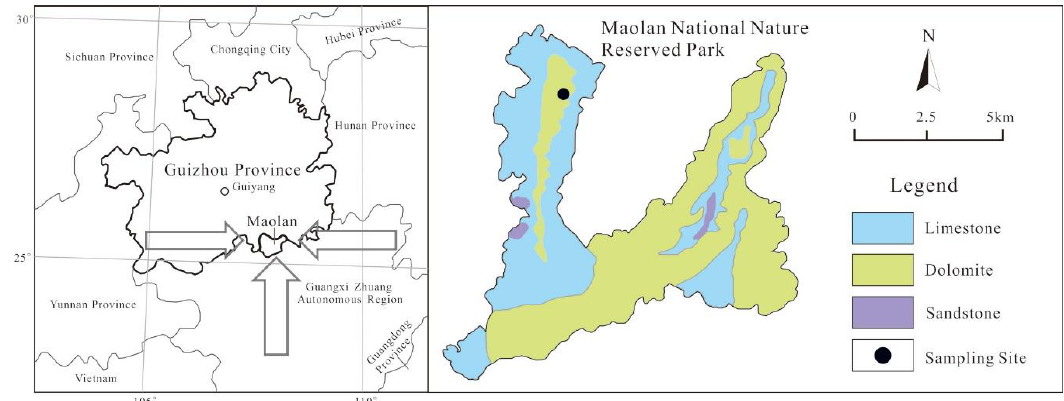
Figure 1. Background of the sampling site in the Maolan National Karst Forest Park (MNKFP).